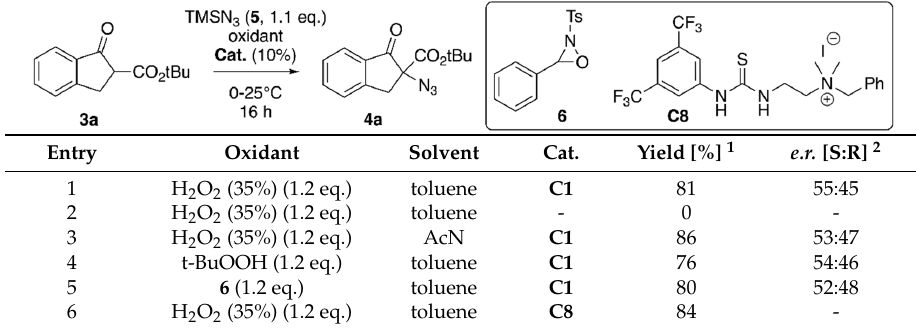
Table 2. α -Azidation of 3a under oxidative conditions using TMSN 3 ( 5